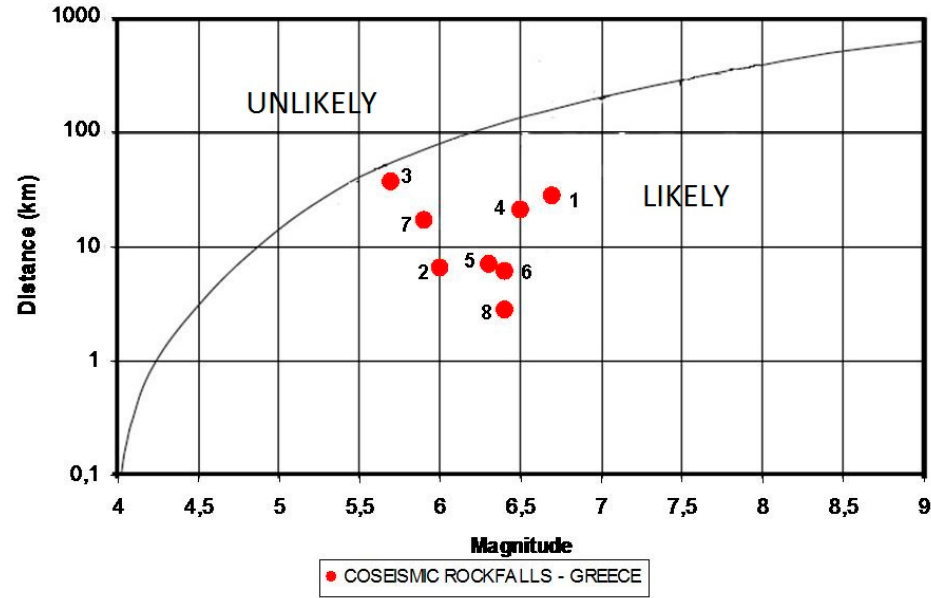
Figure 4. Magnitude–source distance diagram of coseismic rockfalls in Greece.